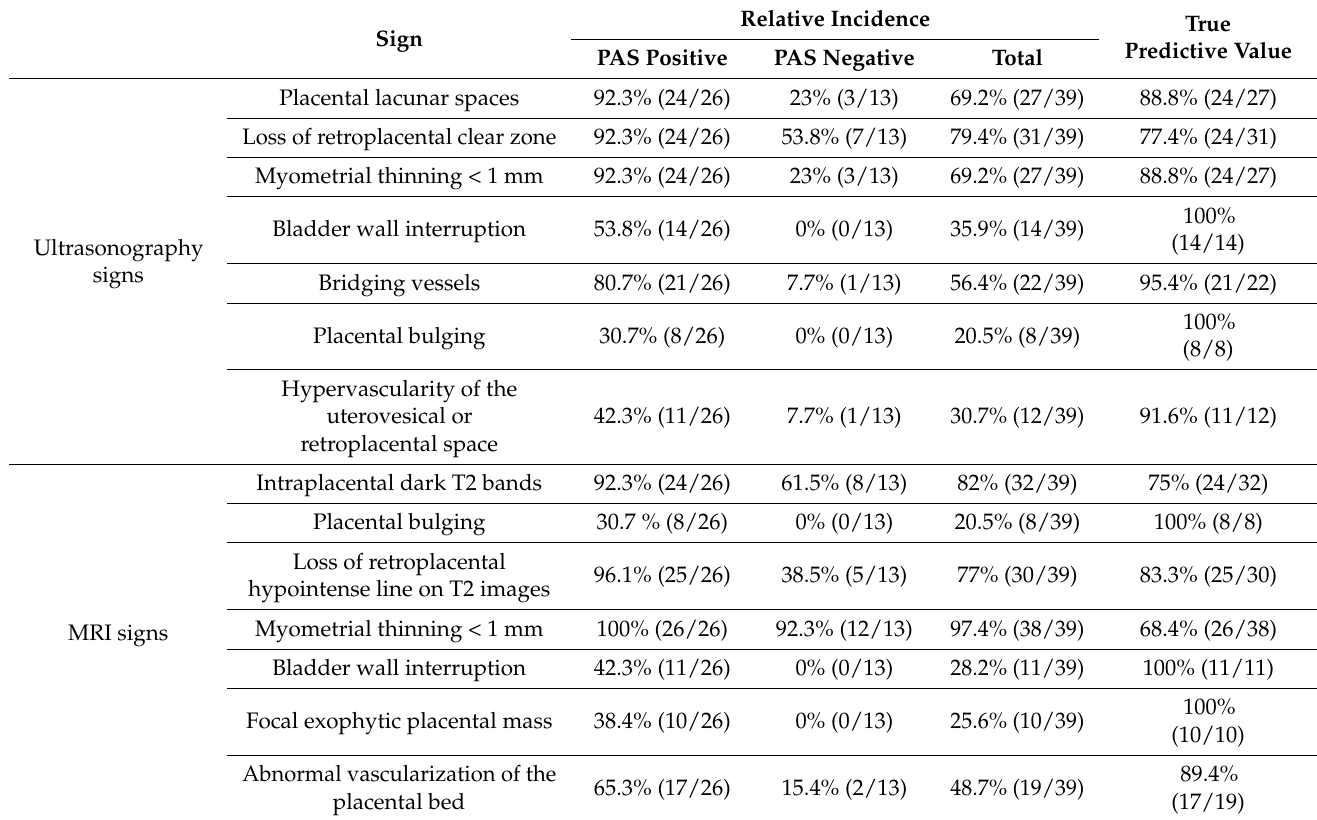
Table 7. Summary table presenting US and MRI signs relative incidence and true predictive value.